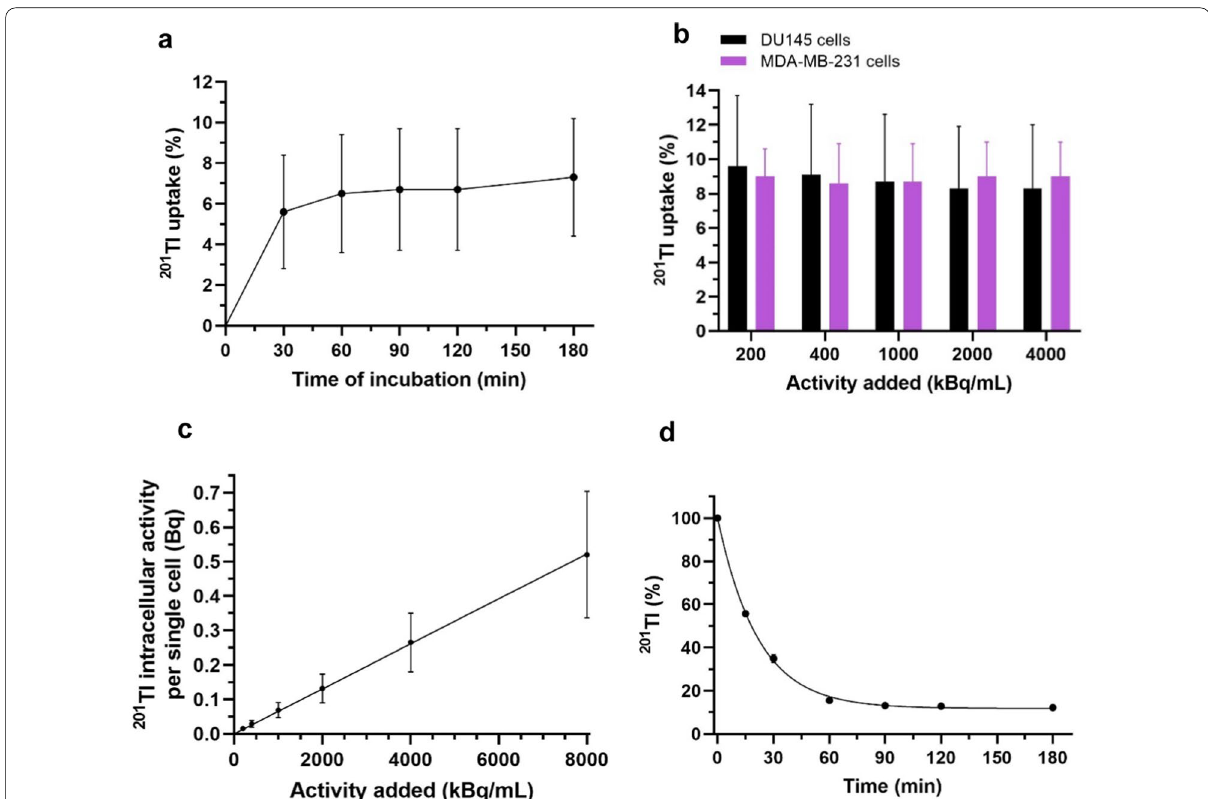
Fig. 2 201 Tl kinetics. a Uptake of 201 Tl in DU145 cells ( n 3) after incubation with 200 kBq/mL [ 201 Tl]TlCl in medium. These results were used to = determine the best incubation time for subsequent radiobiological experiments. b 201 Tl uptake in DU145 cells ( n after 90 min incubation in medium with different activities of [ 201 Tl]TlCl. c 201 Tl intracellular activity per single cell (Bq) versus activity added (kBq/mL) in DU145 cells ( n 3) measured in medium. Graphs b and c show that the increasing activity of 201 Tl does not inhibit its cellular uptake, suggesting = that saturation of uptake mechanisms is not reached at the activities used in this work. d Efflux of 201 Tl in DU145 ( n the preceding uptake assay is defined as 100% at time 0. Radioactive medium was replaced with non-radioactive and 201 Tl activity was measured over time. Data are presented as mean SD, done in triplicates; exponential regression line was fitted in d. Some error bars are smaller than the data ± symbols and hence not